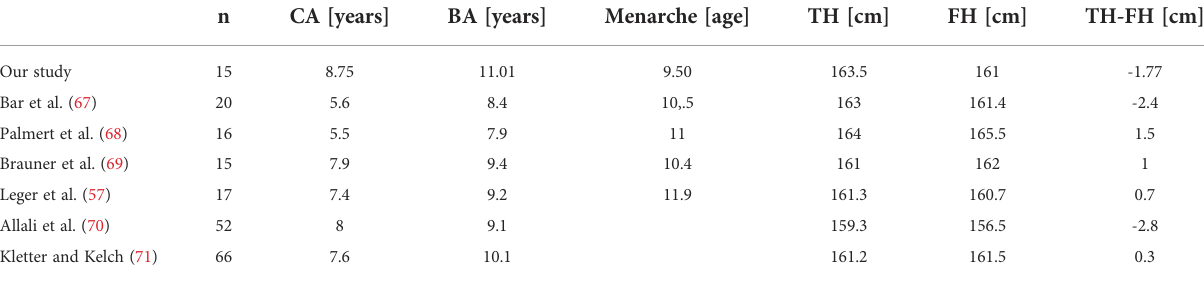
TABLE 9 Comparison of height outcomes in untreated girls with iCPP from different studies. n CA [years] TH-FH [cm] Our study